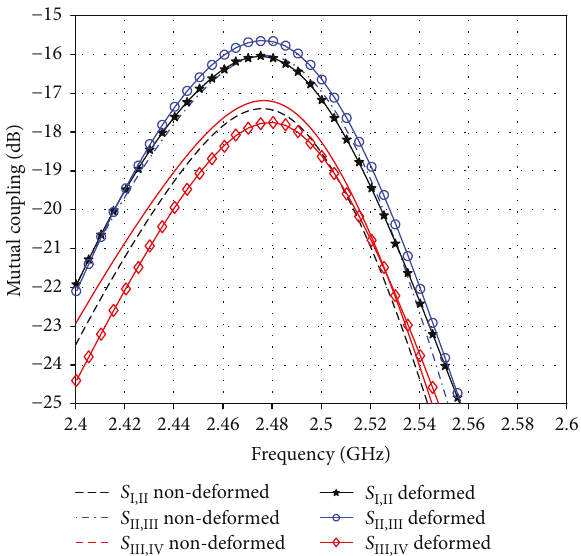
Figure 8: Relevant changes in mutual coupling e ff ects after surface deformation of 4 × 4 array.